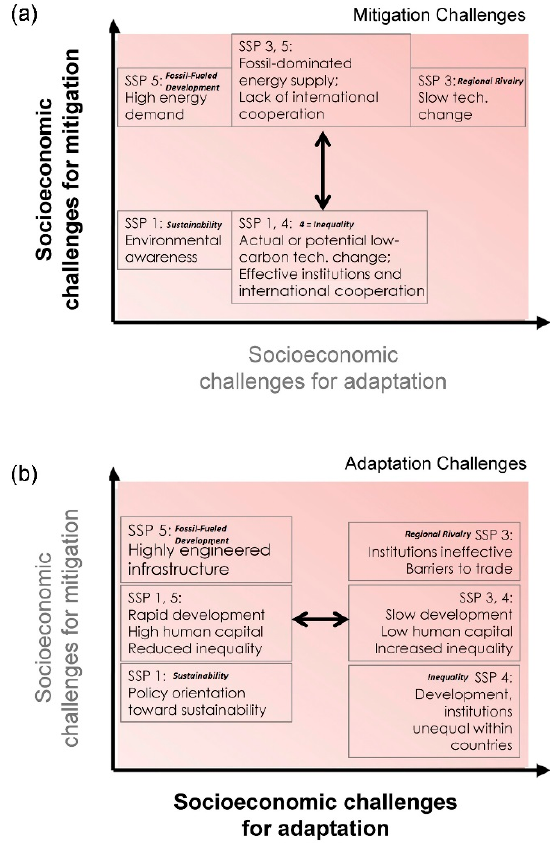
Figure 1. SSP Scenarios from O’Neill et al. [35] (Reprinted with permission. Bold italics added to figure). ( a ) Socioeconomic challenges for mitigation ( b ) Socioeconomic challenges for adaptation